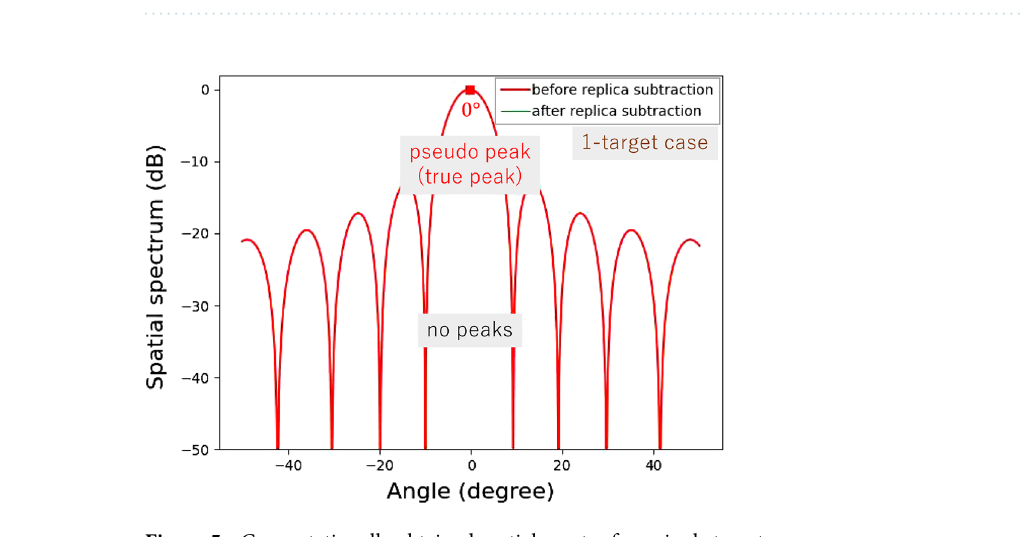
Figure 5. Computationally obtained spatial spectra for a single